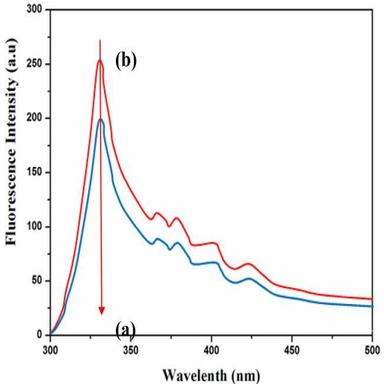
Fluorescence spectra measured at kmax = 310 nm (a) SnO2 and (b) CdO-SnO2 nanocomposite materialobtained using various time 40 min in coumarin solution (sample was illuminated for 40 min of UV light).